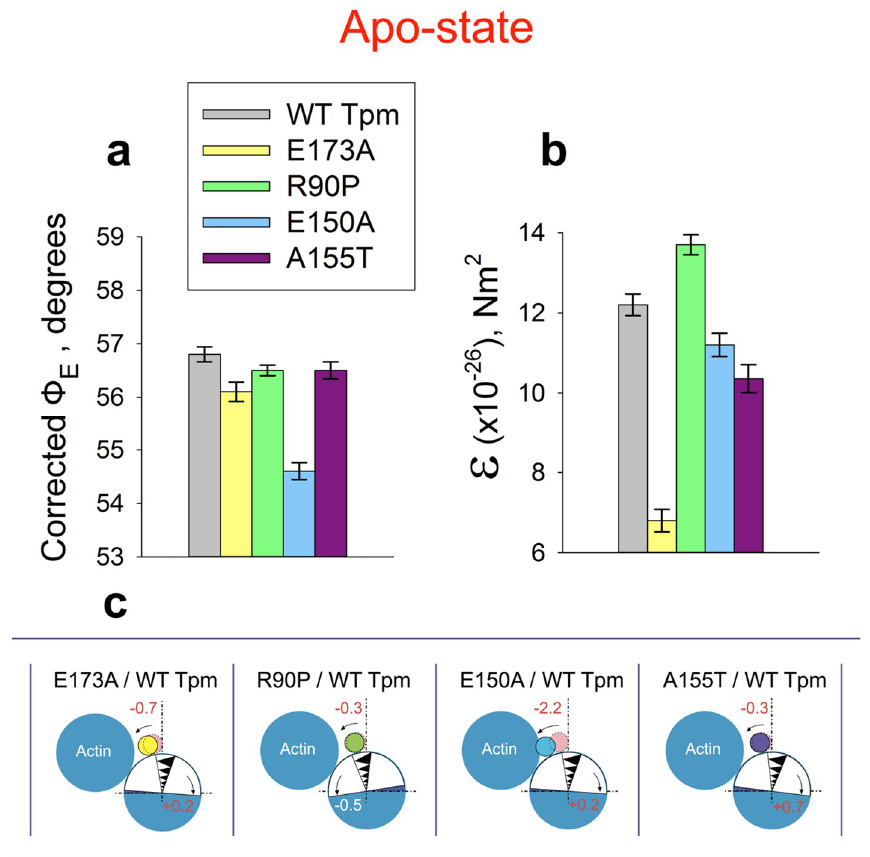
Figure 4. The effect of the E173A, R90P, E150A, and A155T mutations in γ-Tpm on the values of the corrected Φ E angle ( a ) and the bending stiffness ε ( b ) of the polarized fluorescence from 5-IAF bound to Cys190 of tropomyosin revealed in actin filaments. ( c ) Estimated relationship between the changes in the value of Φ E for AF-Tpm and FITC-Actin and spatial rearrangements of Tpm and actin monomer in the presence of the mutant Tpms with respect to the control. Red numbers indicate those changes that lead to the activation of thin filaments. The conditions of the measurements and abbreviations are as in Figure 2. The data represent means of 8–10 ghost fibers for each experimental condition. The corrected Φ E and ε values are significantly altered by point mutations in Tpm ( p < 0.05). Error bars indicate ± SEM.